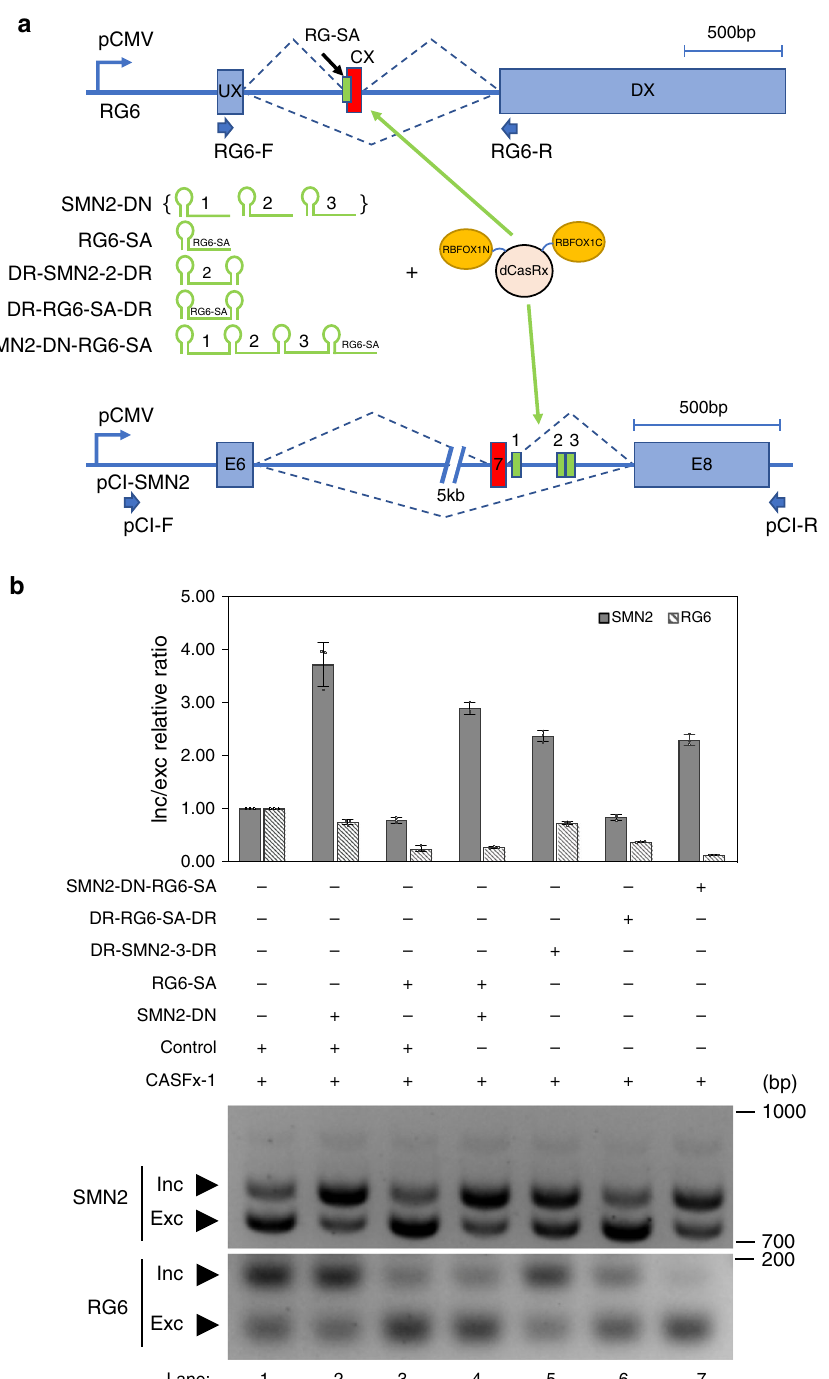
Fig. 3 Simultaneous activation and repression of two independent exons by RBFOX1N-dCasRx-C. a Schematic of the CASFx-1, various gRNA architectures, as well as the RG6 and SMN2 minigenes. SMN2-DN gRNAs is a pool of three gRNAs (SMN2-gRNA-1 through 3), each expressed by a separate plasmid, targeting the corresponding numbered locations on the SMN2 minigene. RG6-SA targets splice acceptor of RG6 cassette exon (CX). DR- SMN2-2-DR is SMN2 target gRNA 2 fl anked by two direct repeats (DR). DR-RG6-SA-DR contains spacer against RG6-CX splice acceptor fl anked by two DRs. SMN2-DN-RG6-SA is a polycistronic pre-gRNA with spacers targeting three DN sites on SMN2 downstream intron and RG6-CX splice acceptors intervened by DRs. b Upper panel shows inclusion/exclusion (inc/exc) ratio fold-changes assayed by qRT-PCR on SMN2 minigene transcripts in cells co- transfected with the two minigene plasmids, CASFx-1 (RBFOX1N-dCasRx-C) and the indicated gRNAs. SMN2 and RG6 splicing changes are represented by gray and slash pattern fi lled bars, respectively. Fold-changes are relative to cells transfected with GFP control (set to 1). Data are represented as mean ± SD ( n = 3). Lower panel shows a gel image of semi-quantitative splicing RT-PCR of RG6 and SMN2 minigene transcripts in cells co-transfected with the two minigene plasmids, CASFx-1 and the indicated gRNAs. Uncropped gel images and qRT-PCR values are included in the Source Data fi